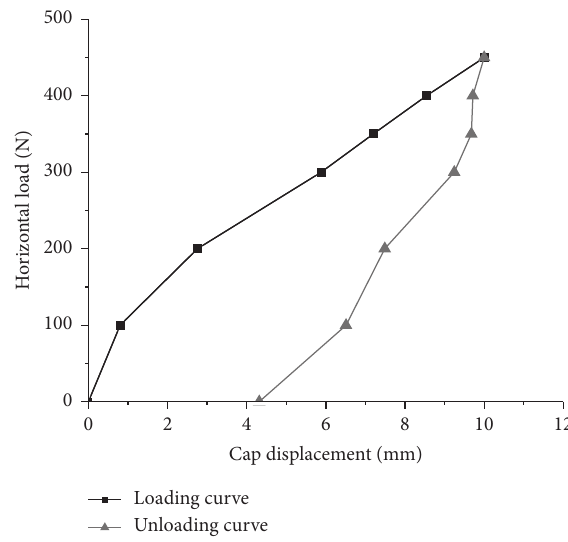
Figure 13: Displacement-load curve of pile caps when pile groups are loaded along y direction. Table 4: Table of horizontal displacement of pile caps.